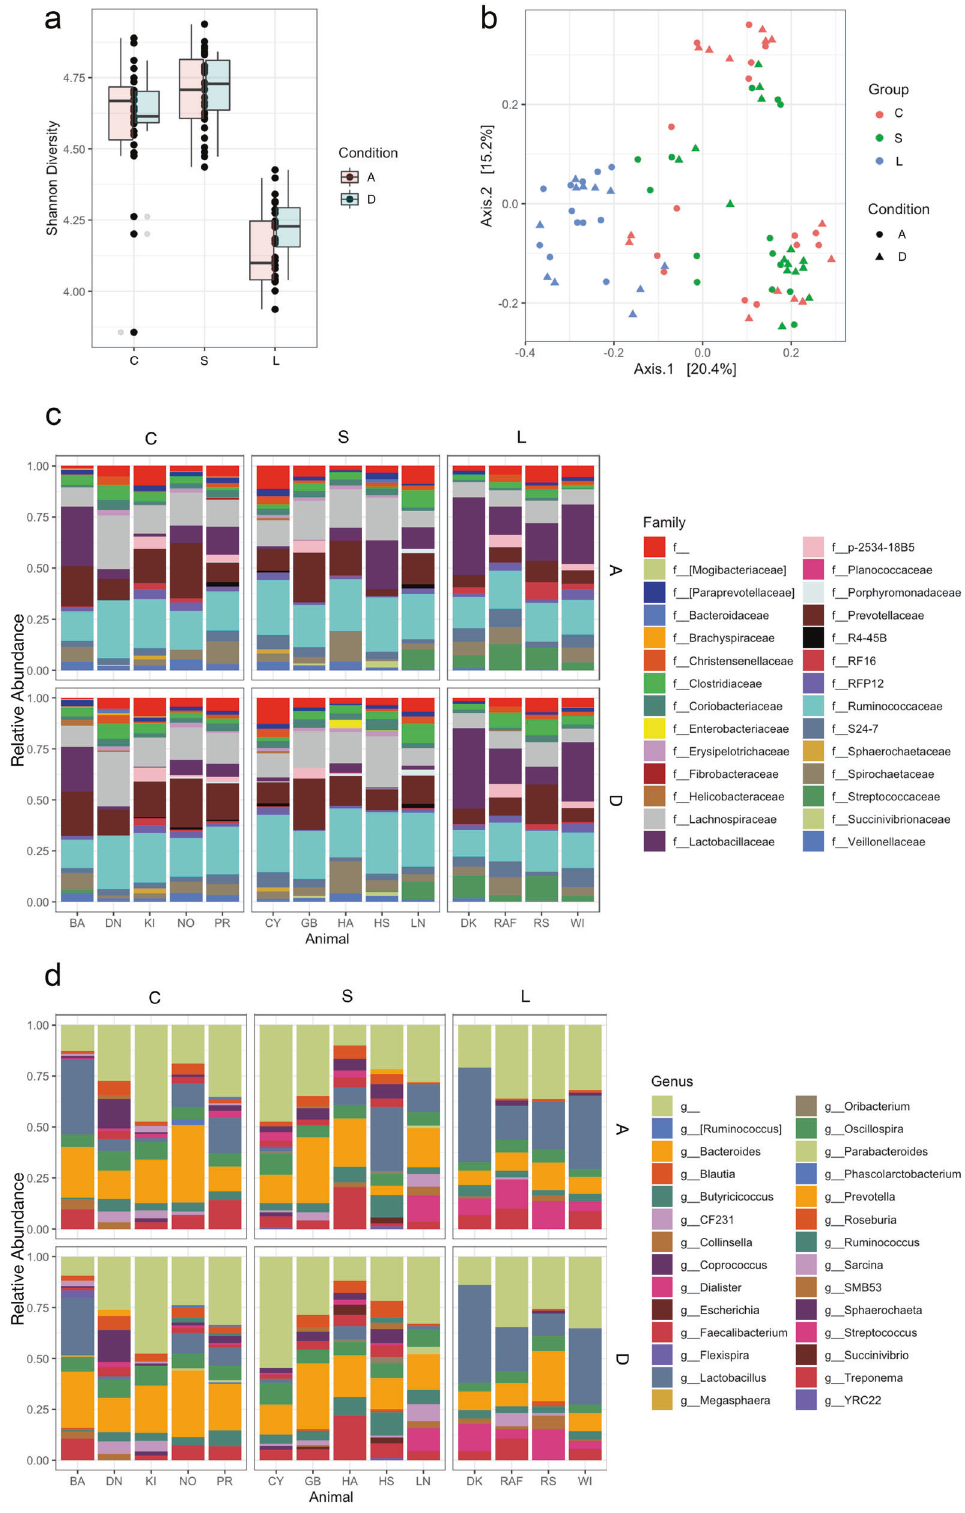
was not signi fi cant. The reduction in fecal microbial alpha-diversity in group L, as suggested by the Shannon Diversity Index (Fig. 3a), is clearly visible in the microbiota composition graph (Fig. 3d). When comparing the three groups (conditions D and A combined), the LEfSe algorithm identi fi ed two genera, Lactoba- cillus and Streptococcus , showing a signi fi cant increase in group